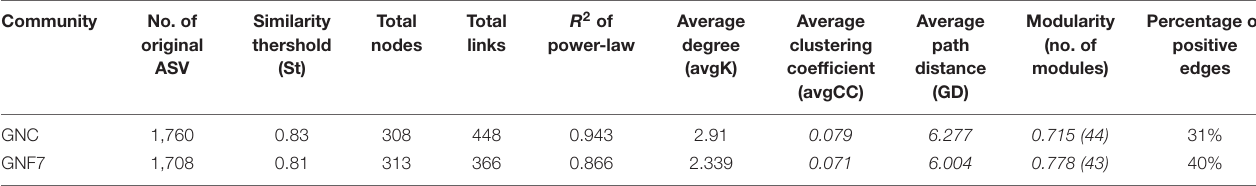
FIGURE 4 | Co-occurrence networks of microbial communities in banana (cv. Grand Nain) root control (GNC) and Pseudomonas simiae PICF7-inoculated (GNF7) plants. This panel shows the modular layout of the networks, with the nodes colored according to their phylum. The green and red lines (links) indicate positive and negative interactions, respectively. The arrow indicates module position in which the PICF7 amplicon sequence variant was found. TABLE 1 | Main topological properties of co-occurrence networks of banana (cv. Grand Nain) root control (GNC) and Pseudomanas simiae PICF7-inoculated (GNF7) plants.